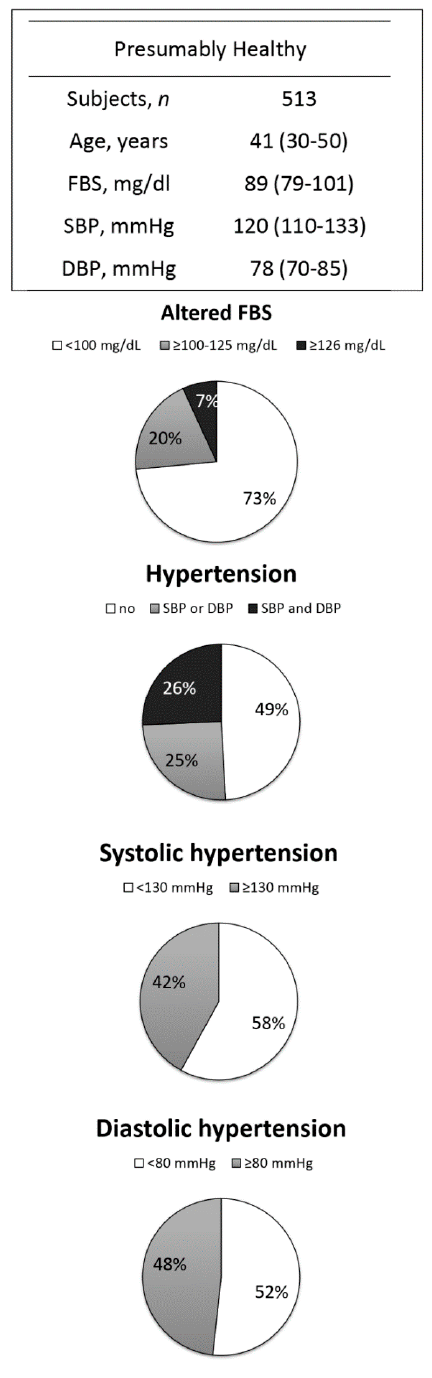
Figure 3. The prevalence of altered fasting blood sugar (FBS) levels, systolic hypertension, and diastolic hypertension in the presumably healthy subgroup. The presumably healthy subgroup was defined as participants who were 18–65 years old with no history or previous diagnosis of NCDs, drug dependency, or chronic treatment with drugs. According to the American Diabetes Association (2016) [21], impaired glucose tolerance was defined as FBS ≥ 100–125 mg/dL (gray) and diabetes mellitus (DM)-suspected was defined as ≥ 126 mg/dL (black). Systolic hypertension was defined as blood pressure ≥ 130 mmHg and diastolic hypertension as blood pressure ≥ 80 mmHg. Data are presented as medians and interquartile ranges (table) and as proportions of participants